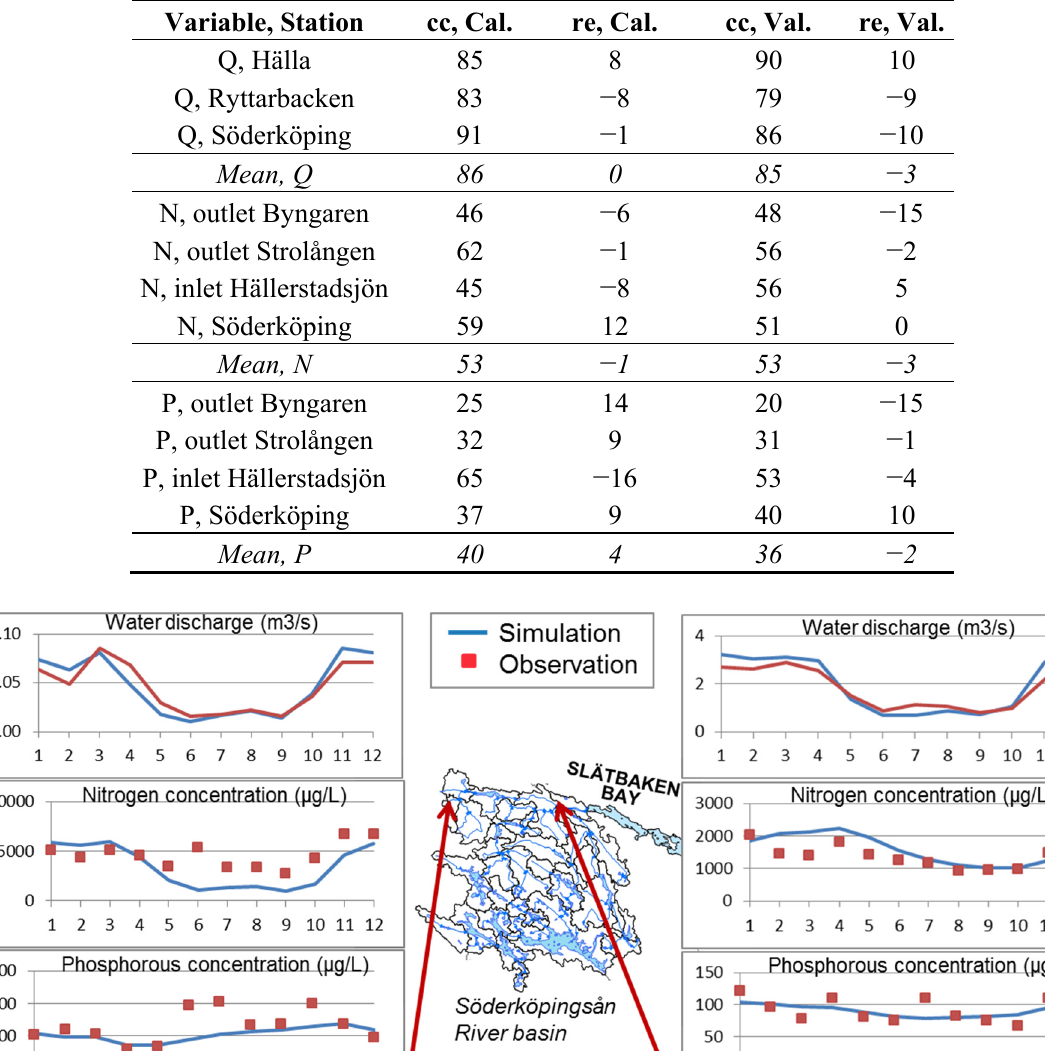
Table 2. HYPE model performance in the Söderköpingsån catchment (cc = correlation coefficient, re = relative error; all in %). Cal. = calibration period: 2000–2009 and Val. = validation period: 1990–1999.